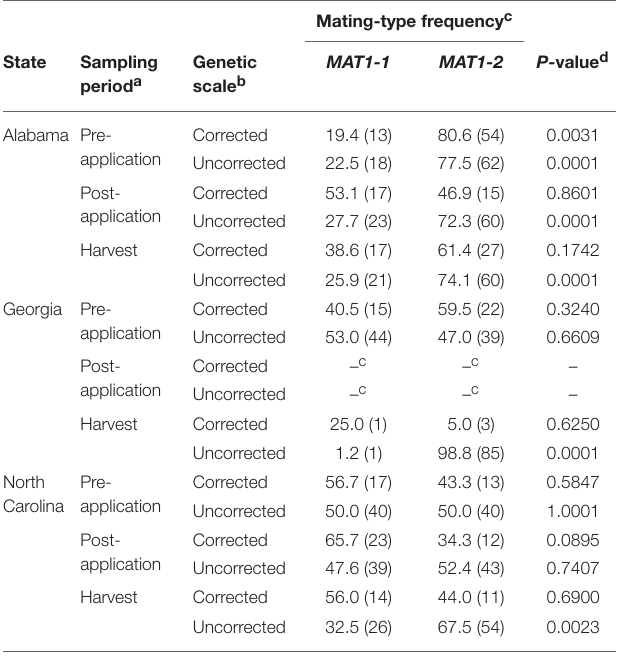
TABLE 6 | Frequency and distribution of mating-type ( MAT ) genes among isolates of Aspergillus flavus in soil from fields in the southeastern United States treated with Afla-Guard and AF36 biocontrol strains in